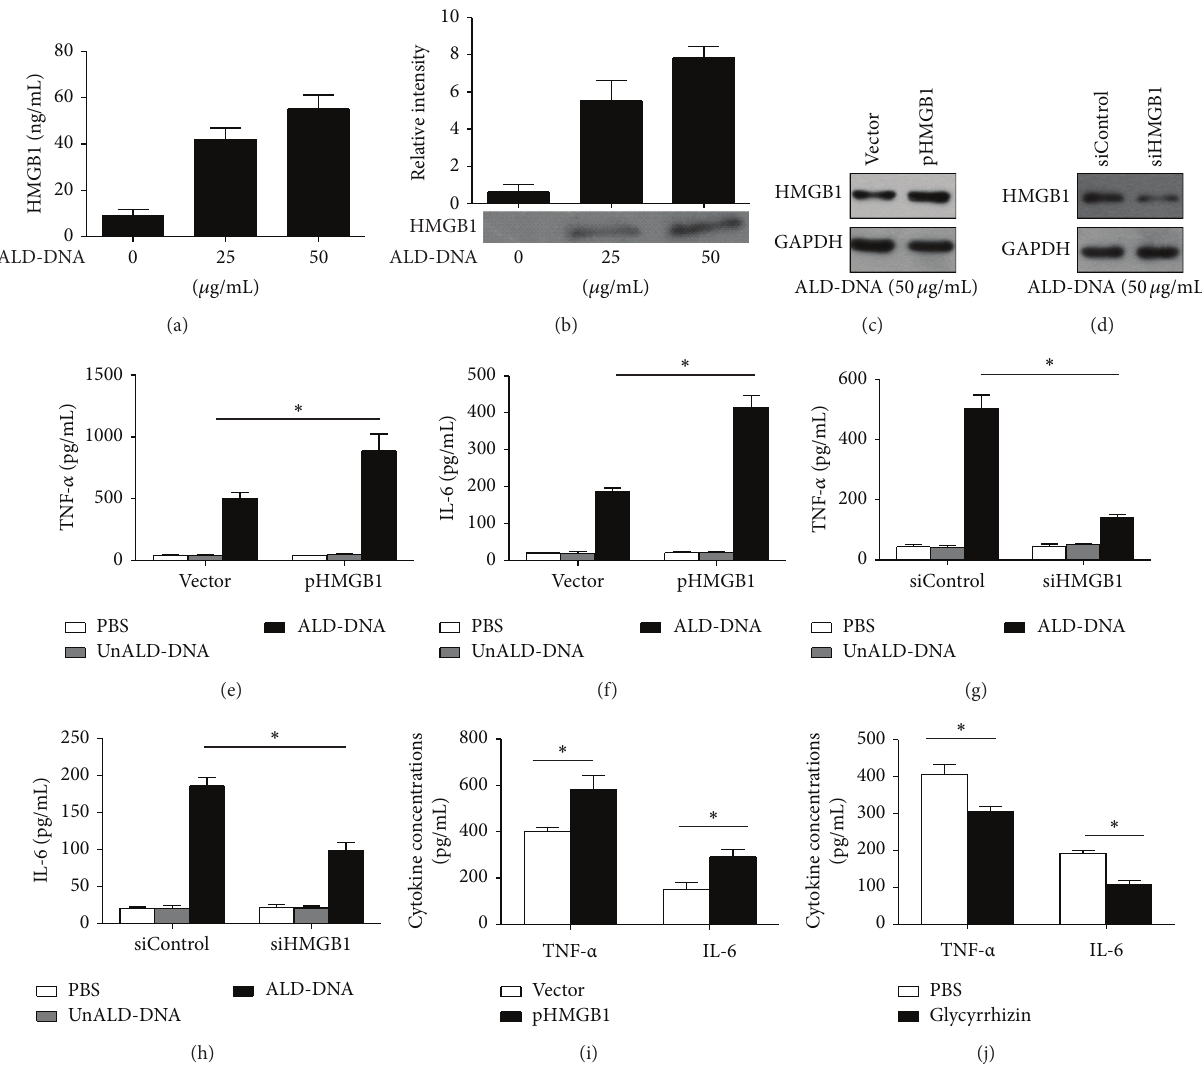
Figure 4: HMGB1 aggravated macrophage inflammatory response. (a-b) RAW264.7 cells were stimulated with ALD-DNA (0, 25, 50 𝜇 g/mL) for 24 h, levels of HMGB1 in the supernatants of RAW264.7 cells were analyzed by ELISA (a) and western blot analysis (b). Data are means ± SD of three independent experiments. (c-d) The efficiency of HMGB1 overexpression (c) and knockdown (d) was monitored by representative immunoblot of three independent experiments in ALD-DNA-stimulated RAW264.7 cells. (e-f) RAW264.7 cells were transfected with pHMGB1 or vector. 72 h after transfection, RAW264.7 cells were stimulated with PBS, UnALD-DNA or ALD-DNA (50 𝜇 g/mL) followed by analyzing the levels of TNF- 𝛼 (e) and IL-6 (f) in the culture supernatants of RAW264.7 cells. Data are means ± SD of three independent experiments. (g-h) RAW264.7 cells were transfected with control siRNA (200nM) or HMGB1 siRNA (siHMGB1, 200 nM). After 72 h RAW264.7 cells were stimulated with PBS, UnALD-DNA or ALD-DNA (50 𝜇 g/mL). ELISA assay was used to analyze the levels of TNF- 𝛼 (g) and IL-6 (h) in the culture supernatants of RAW264.7 cells. Data are means ± SD of three independent experiments. (i-j) CD11b + /F4/ 80 high renal macrophages were sorted from nephritic single-cell suspensions from (i) pHMGB1- or empty vector-treated, (j) glycyrrhizin- or PBS- treated SLE mice by flow cytometry. Macrophages (2 × 10 5 /mL) were stimulated with ALD-DNA (50 𝜇 g/mL) for 24 h. The supernatants were collected and assayed for the TNF- 𝛼 and IL-6 concentrations using ELISA. Data are means ± SD from 8 mice in each group. ∗ 𝑃 < 0.05